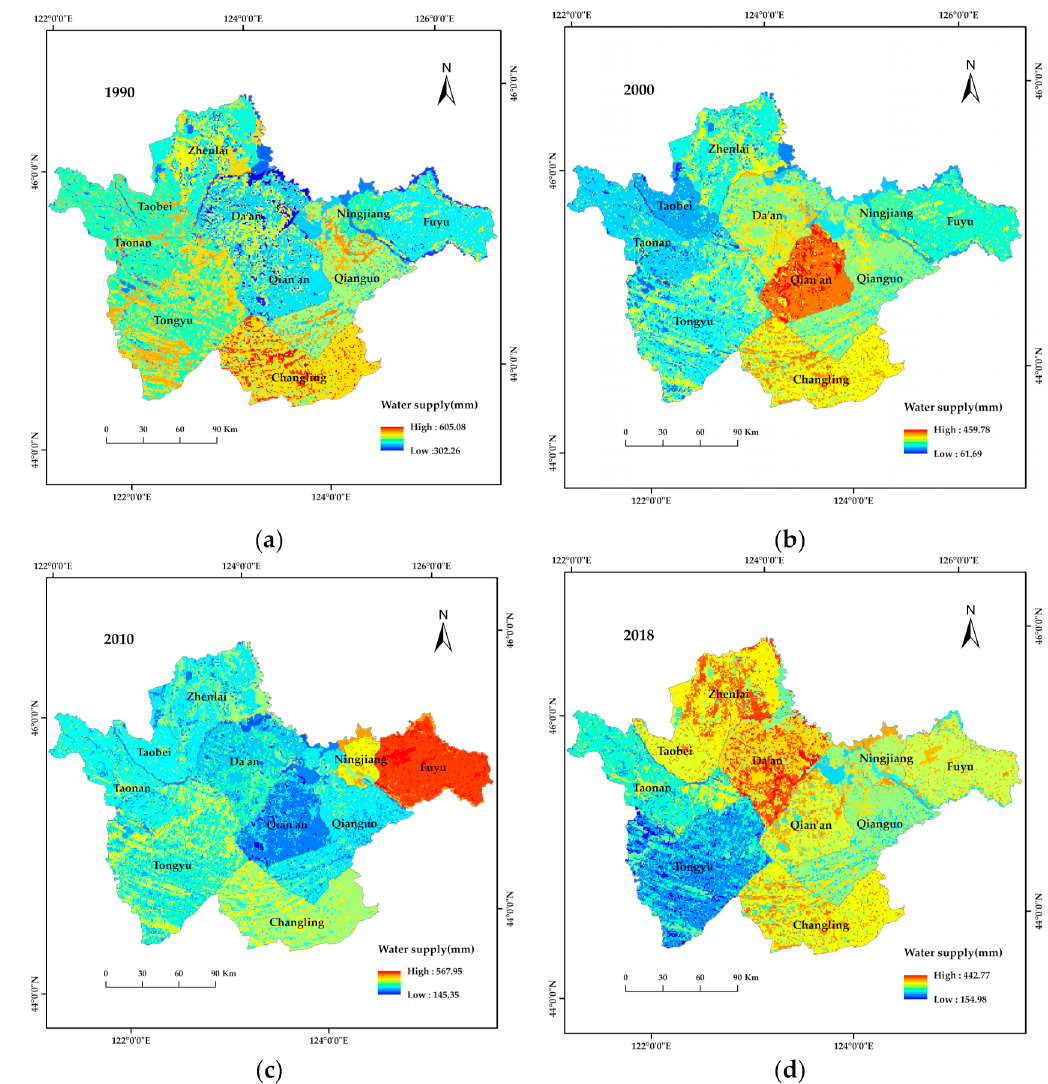
Figure 8. Spatial distribution of water supply in western Jilin Province from 1990 to